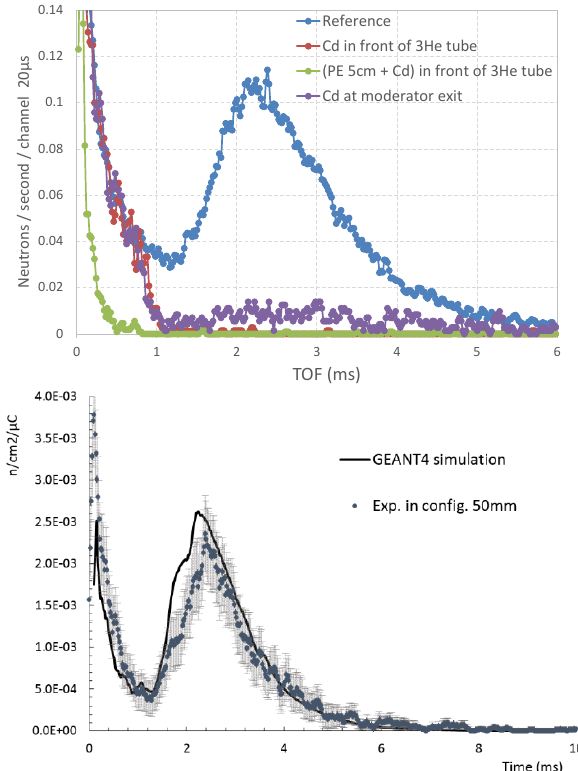
Fig. 8. The comparison of the ToF spectrum between experimental data and Geant4